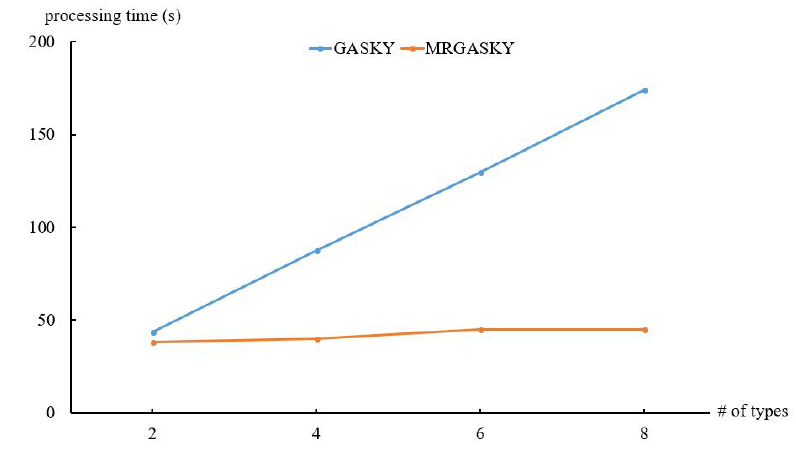
Figure 18. Processing Time of US_B.